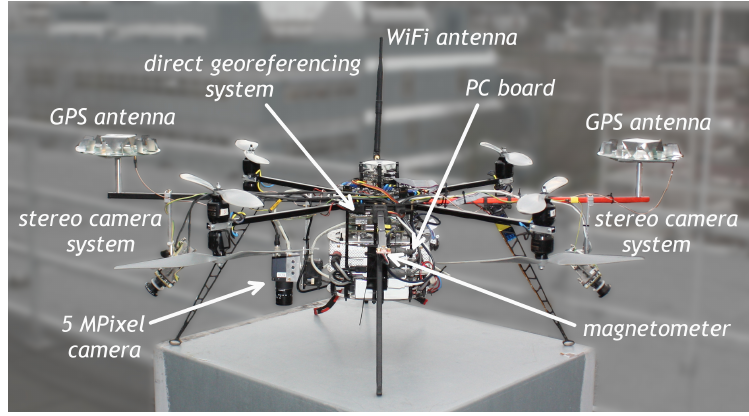
Figure 3. The UAV platform, equipped with different sensors and